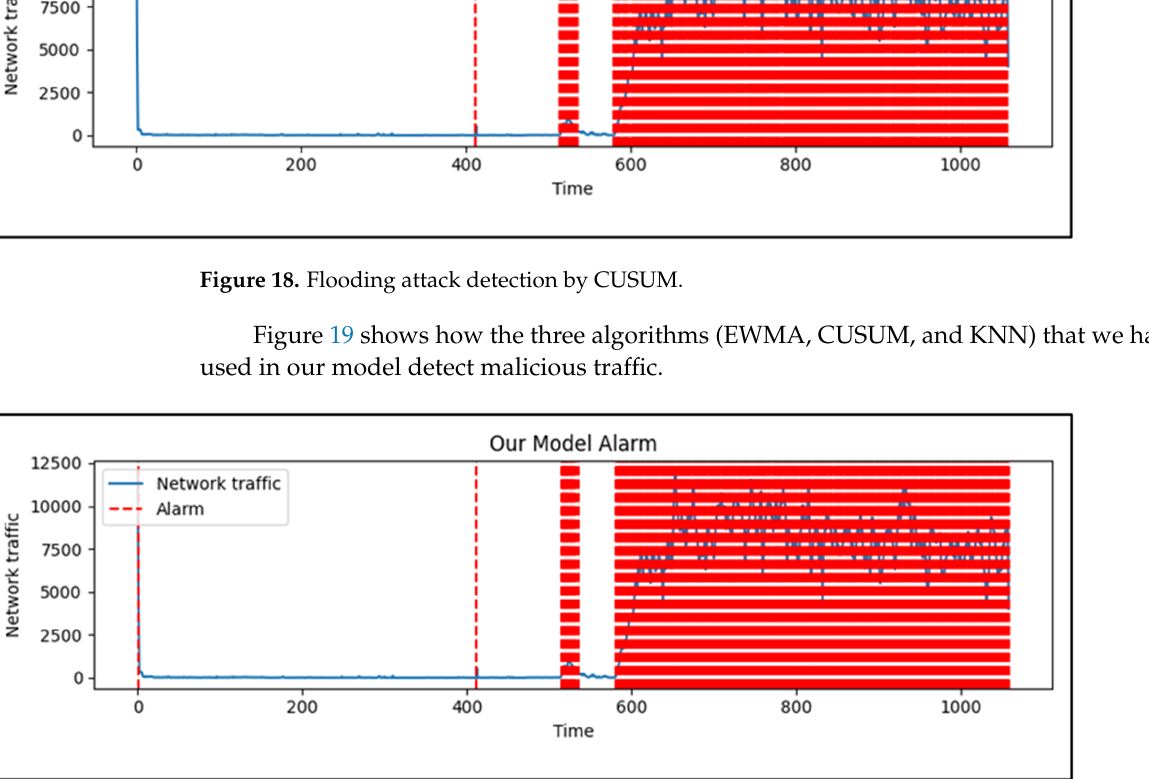
Figure 19. Flooding attack detection by our model (EWMA, CUSUM, and KNN).